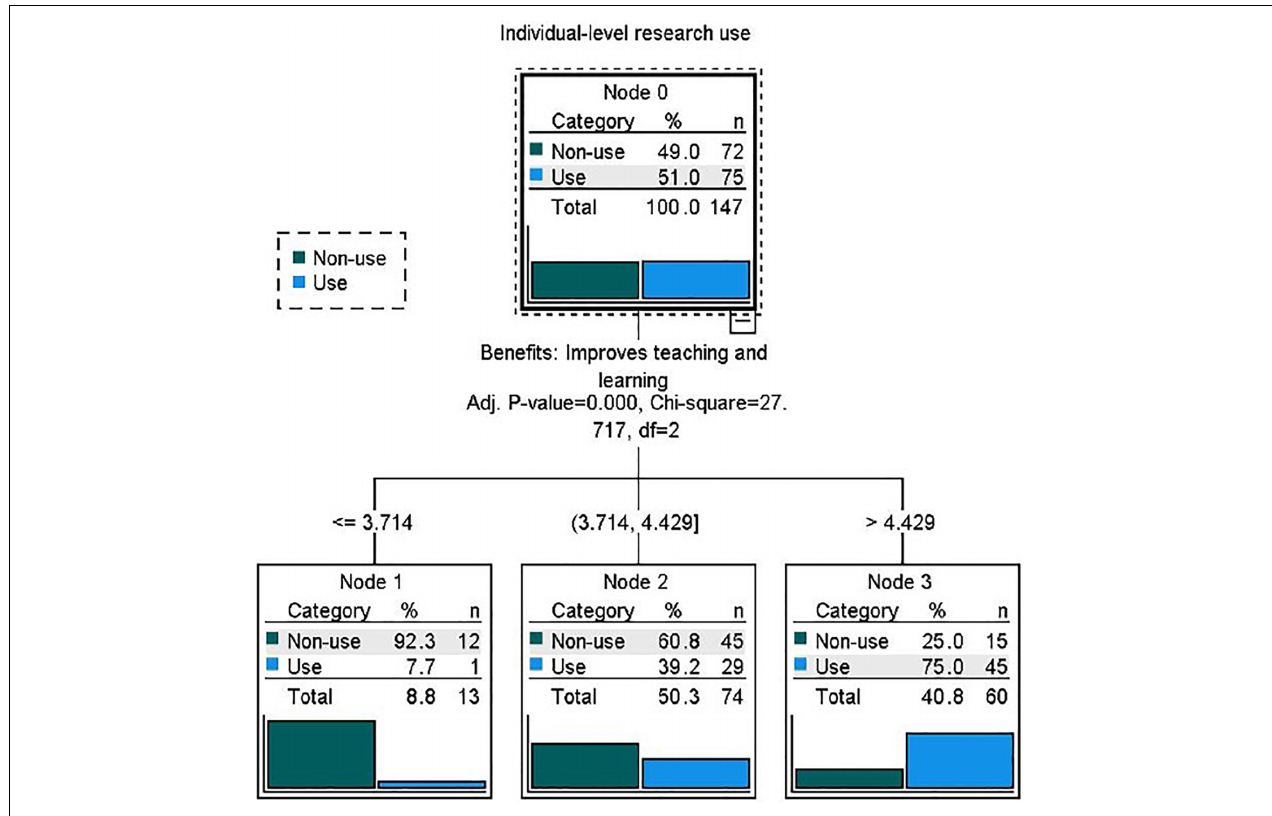
FIGURE 1 | Decision classification tree for the benefits of research-use factors. Light gray shading within terminal nodes denotes the final classification.